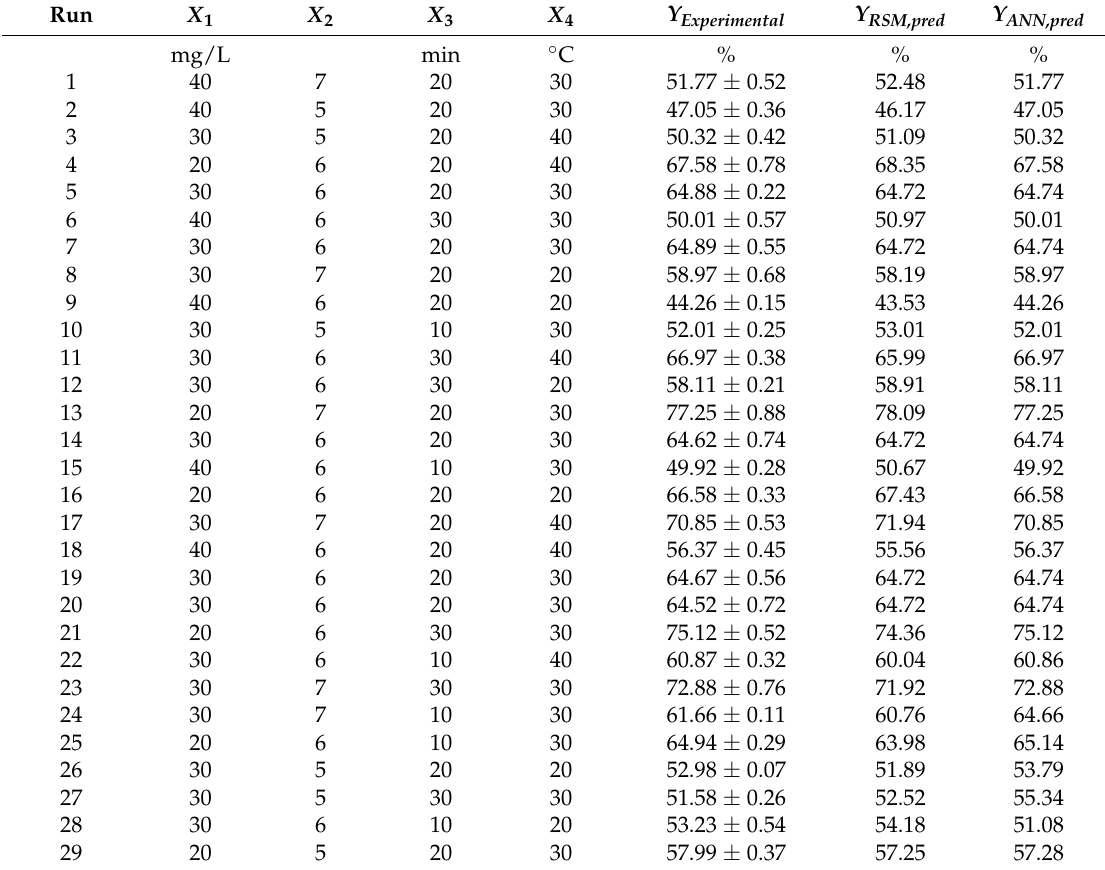
Table 2. Experimental and predicted values of Cd(II) ions removal by nZVI/rGO